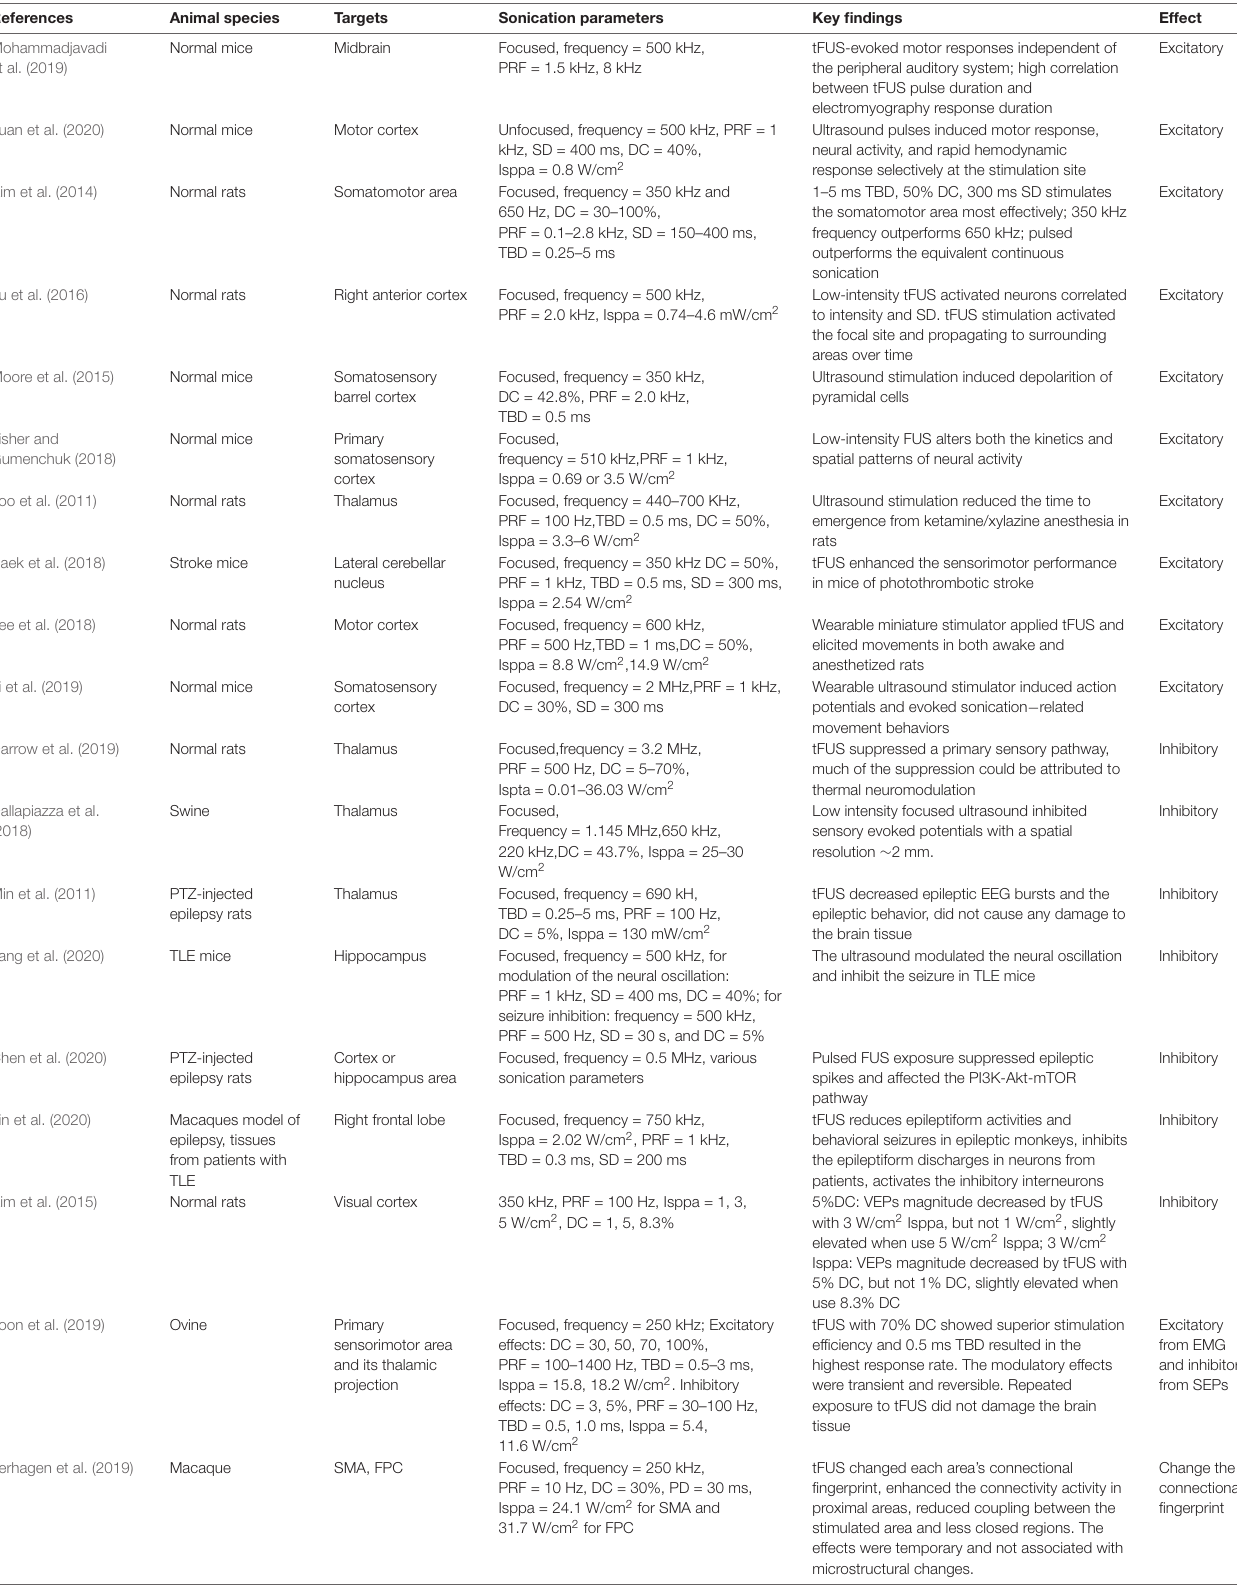
TABLE 1 | tFUS neuromodulation studies in